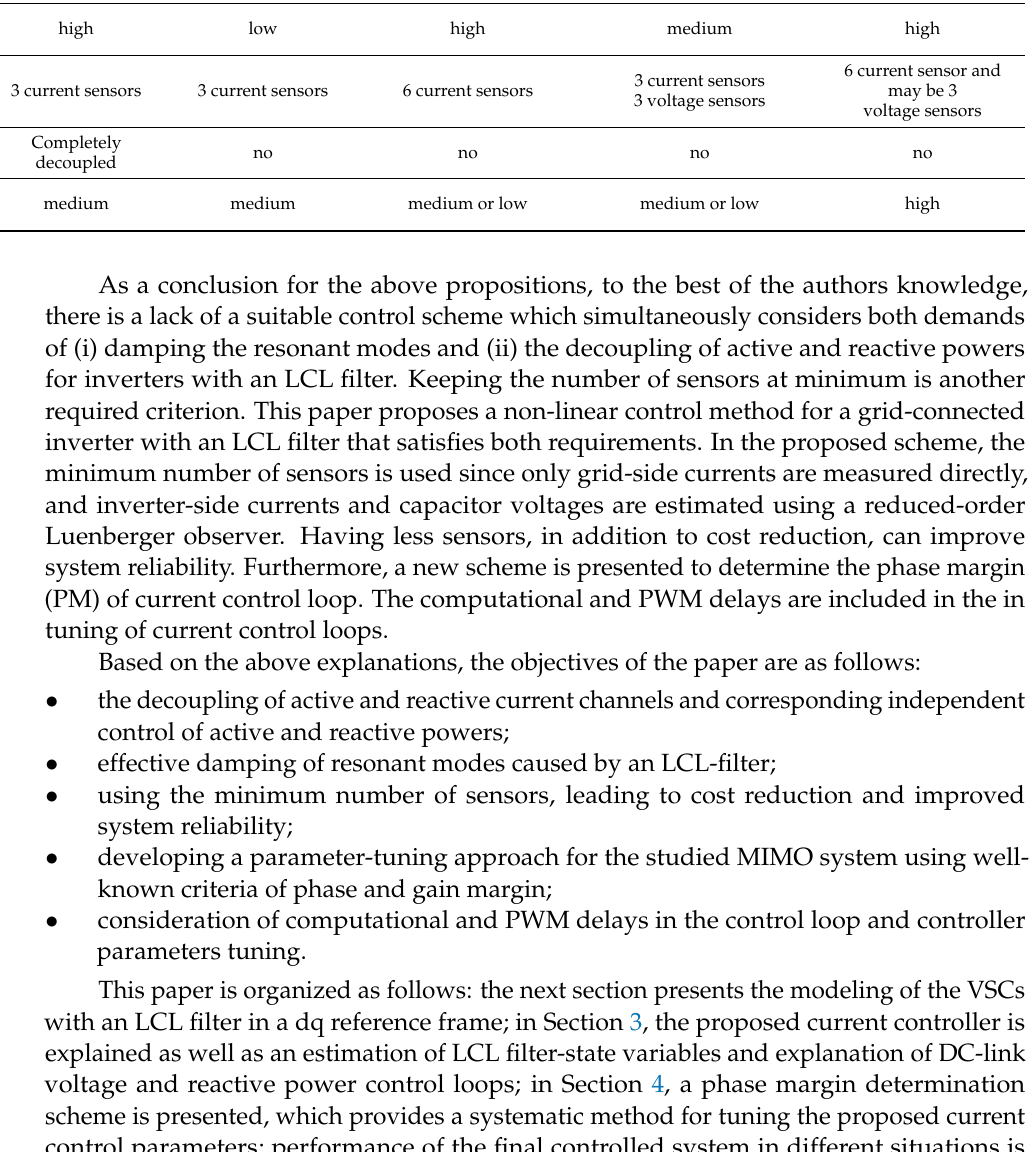
Table 1. Different active damping control schemes for a grid-connected inverter with LCL-filter.